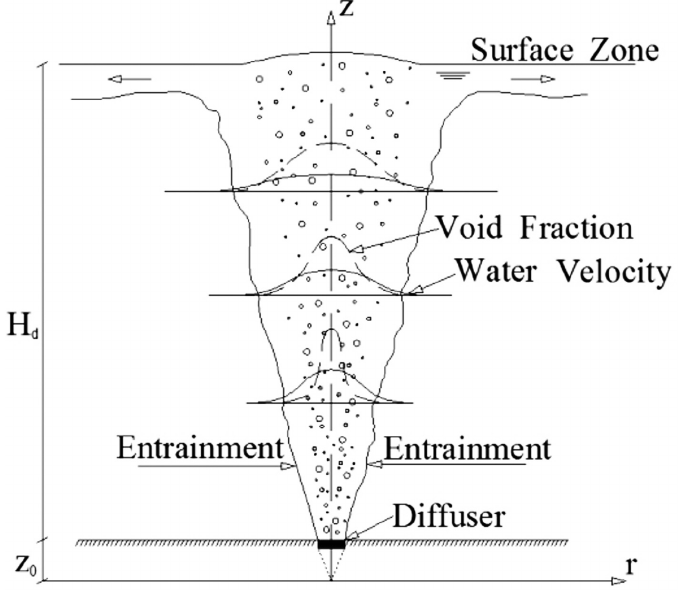
Figure 1 - Sketch of a round bubble plume in stagnant